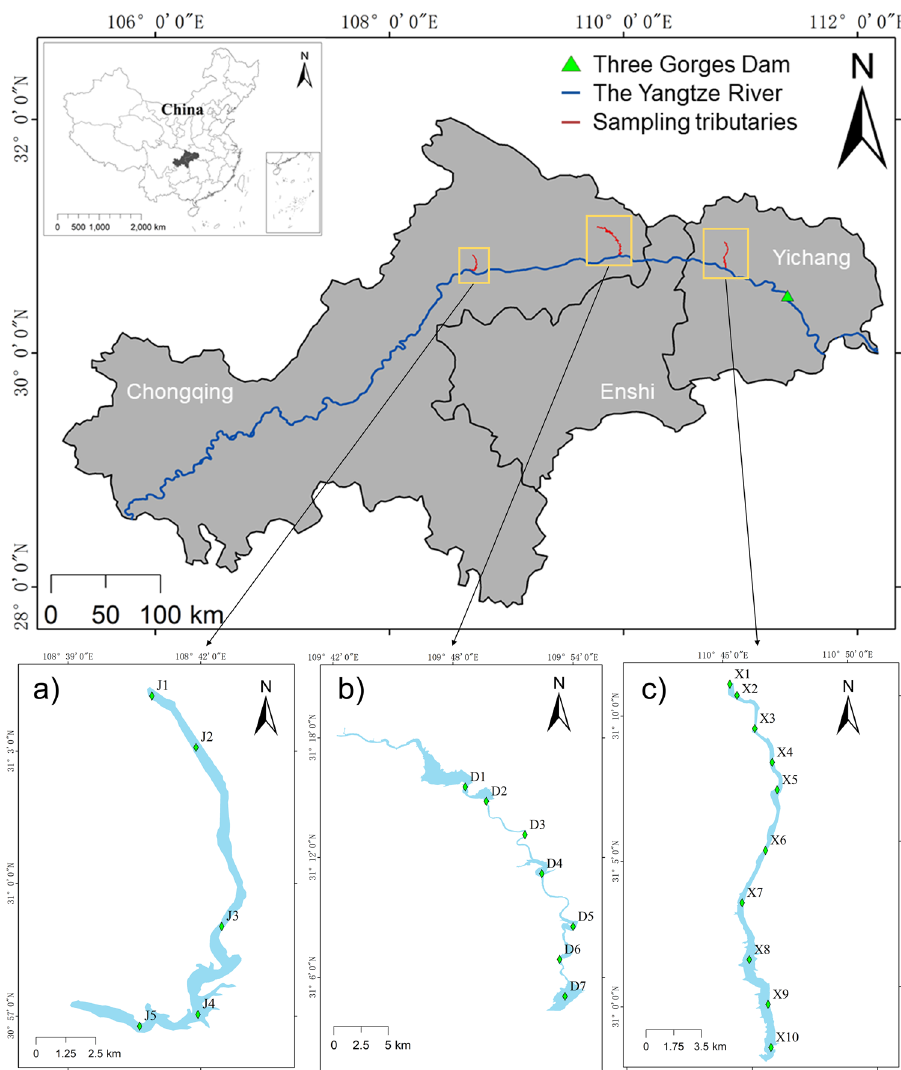
Figure 1. Sampling sites in three typical tributaries of the Yangtze River in TGR area. The three tributaries were ( a ) Xiaojiang River, ( b ) Daning River, and ( c ) Xiangxi River. The basic geographic information was obtained from the National Geomatics Center of China (NGCC) and generated using the ArcGIS 10.7 (http:// www. esri.